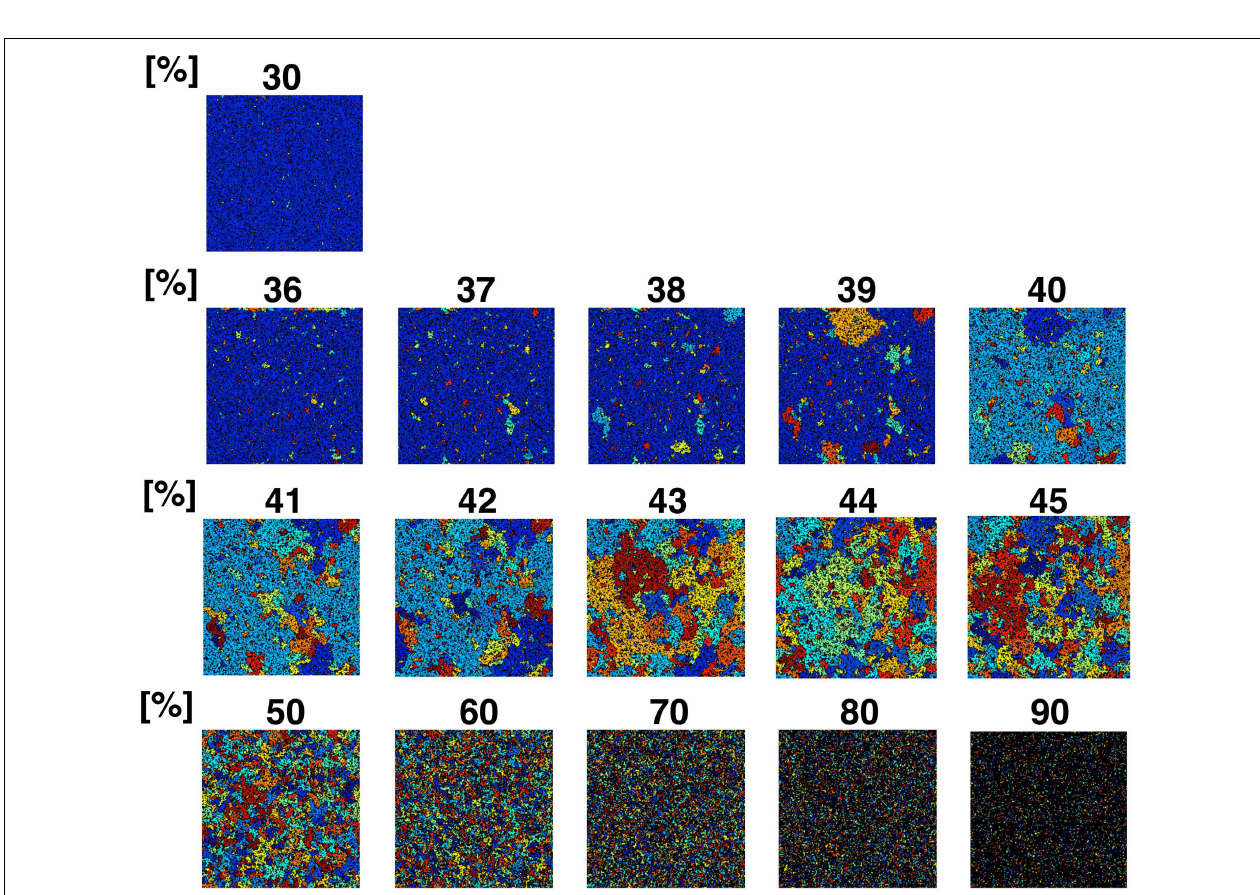
FIGUREA2 |The histogram shows the distribution of the NRO cluster size in 5,000 of completed CCA40, s2000 (A) and completed CCA50, s700 (B). The peaks of the respective histograms